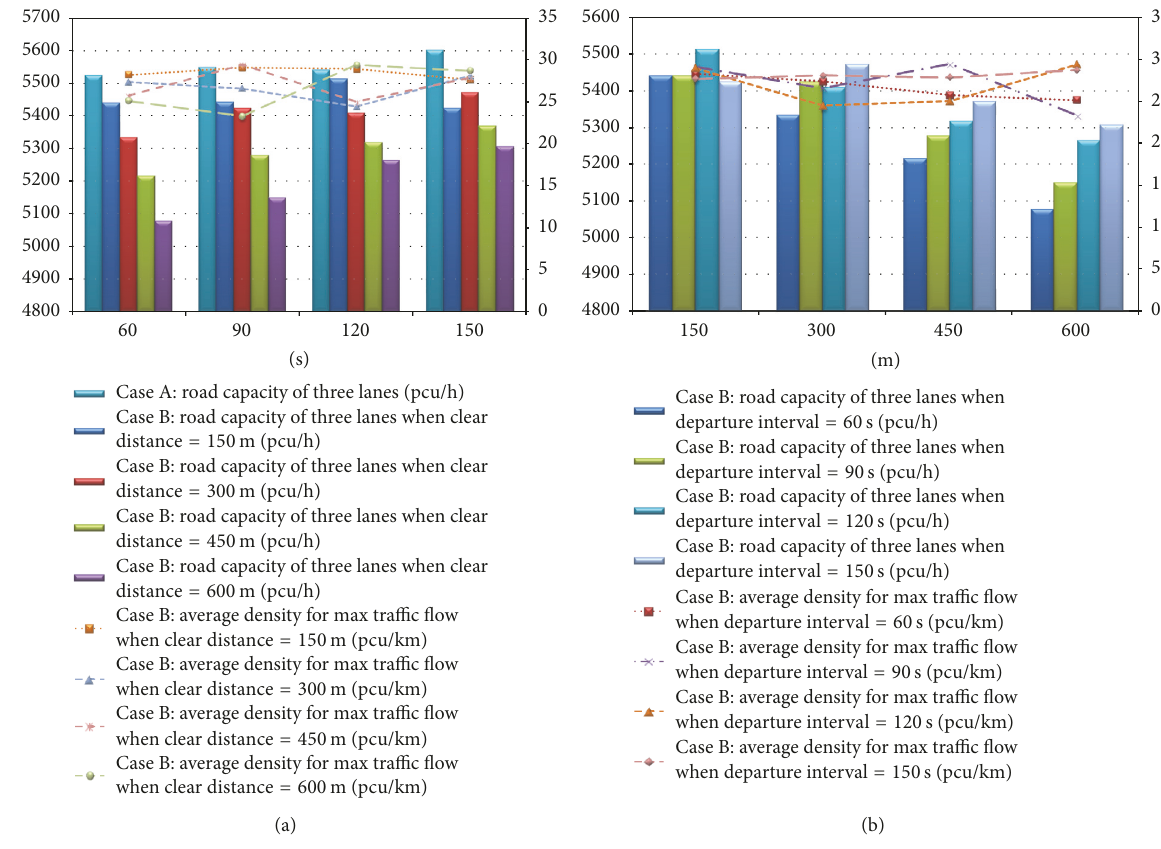
Figure 14: Road capacity of three lanes in Case A and Case B with different bus departure interval and clear distance combinations. (a) Road capacity of three lanes with different bus departure intervals. (b) Road capacity of three lanes with different distances. Table 1: Suitable traffic conditions for BLIP